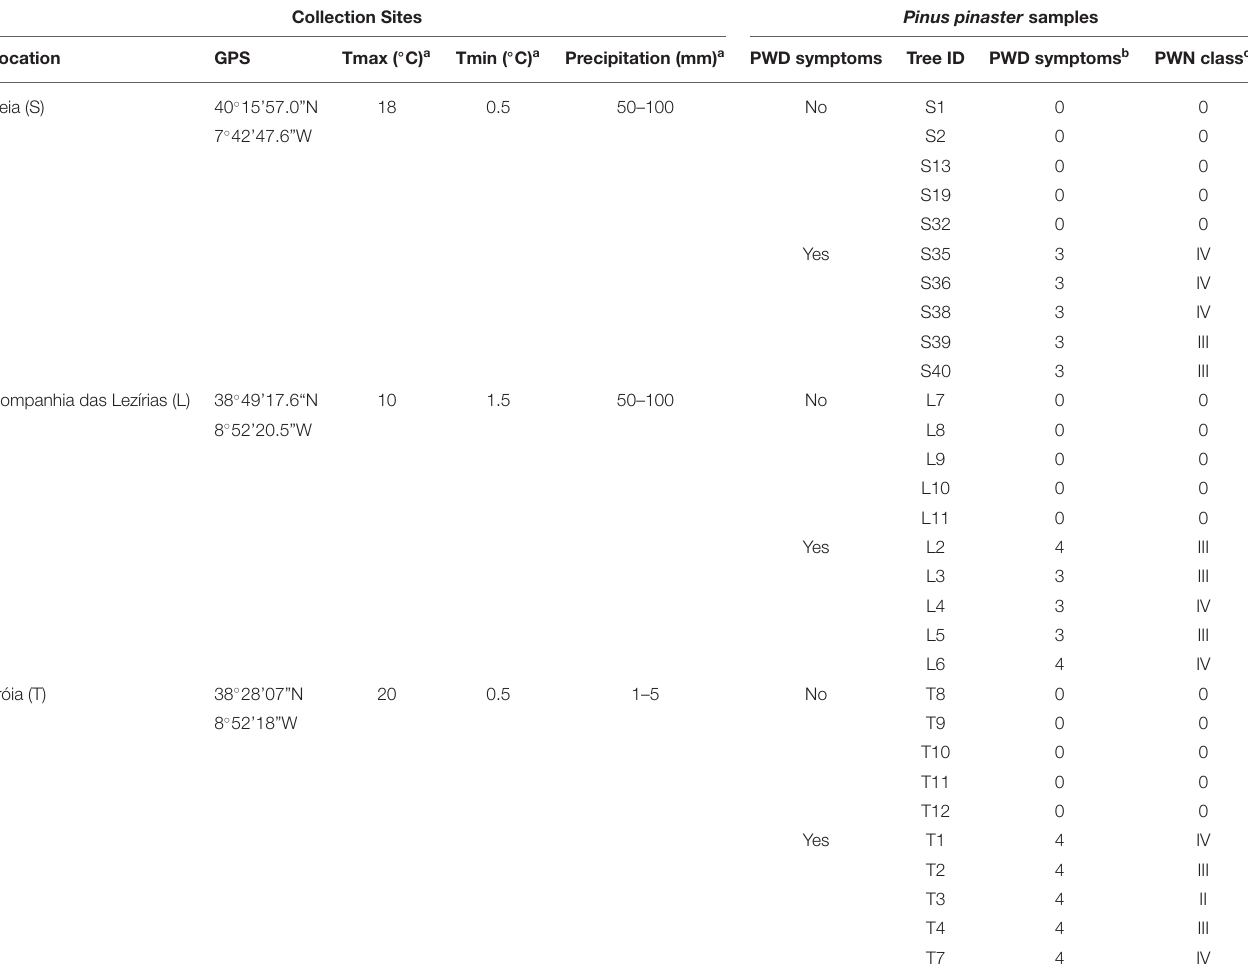
TABLE 1 | Characterization of geographic and climate conditions for each collection site (Seia, Tróia, Companhia das